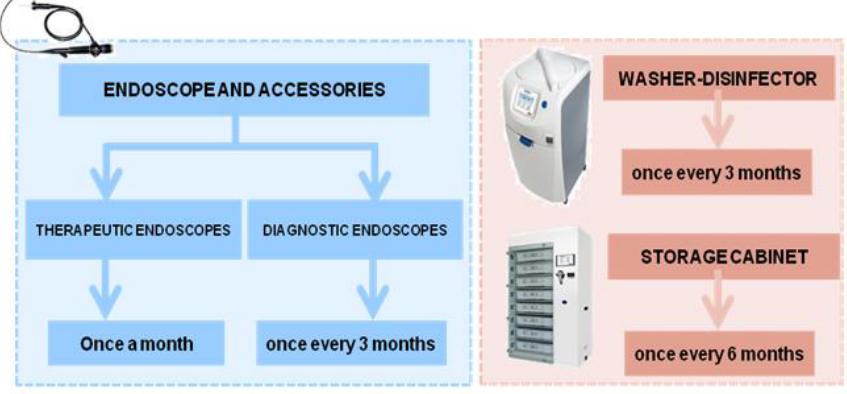
Figure 1. Microbiological surveillance